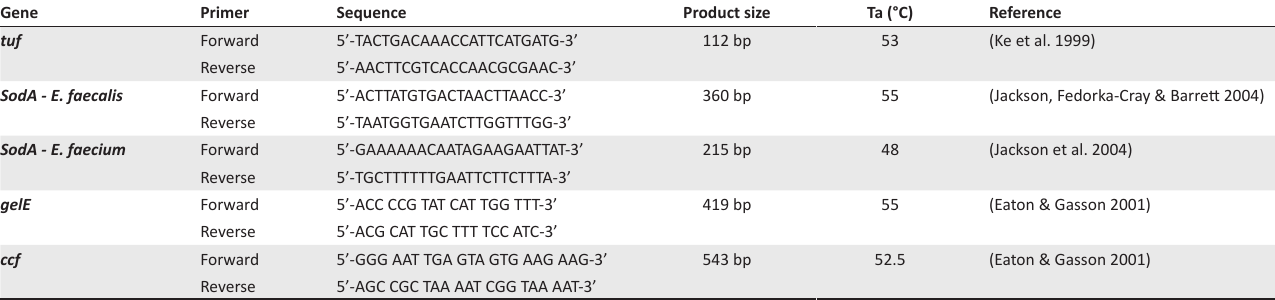
TABLE 2: Target genes, oligonucleotide primer sequences, amplicon sizes and annealing temperatures used for the detection of Enterococcus faecalis and Enterococcus faecium. Gene